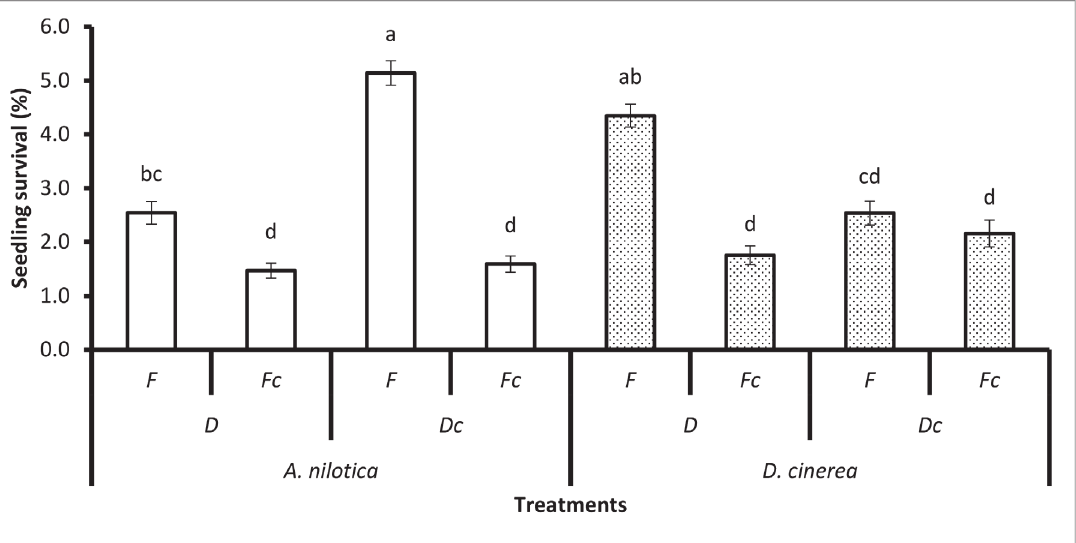
Fig 5. The treatment combination effects of seed species ( A . nilotica , D . cinerea ), dung (D) (and no dung (Dc)), fire (F) (and no fire (Fc)) on seedling survival during the dry season. Bars represent standard errors (S.E). Same letters on the bars mean that P > 0.05. A LSD post hoc test was